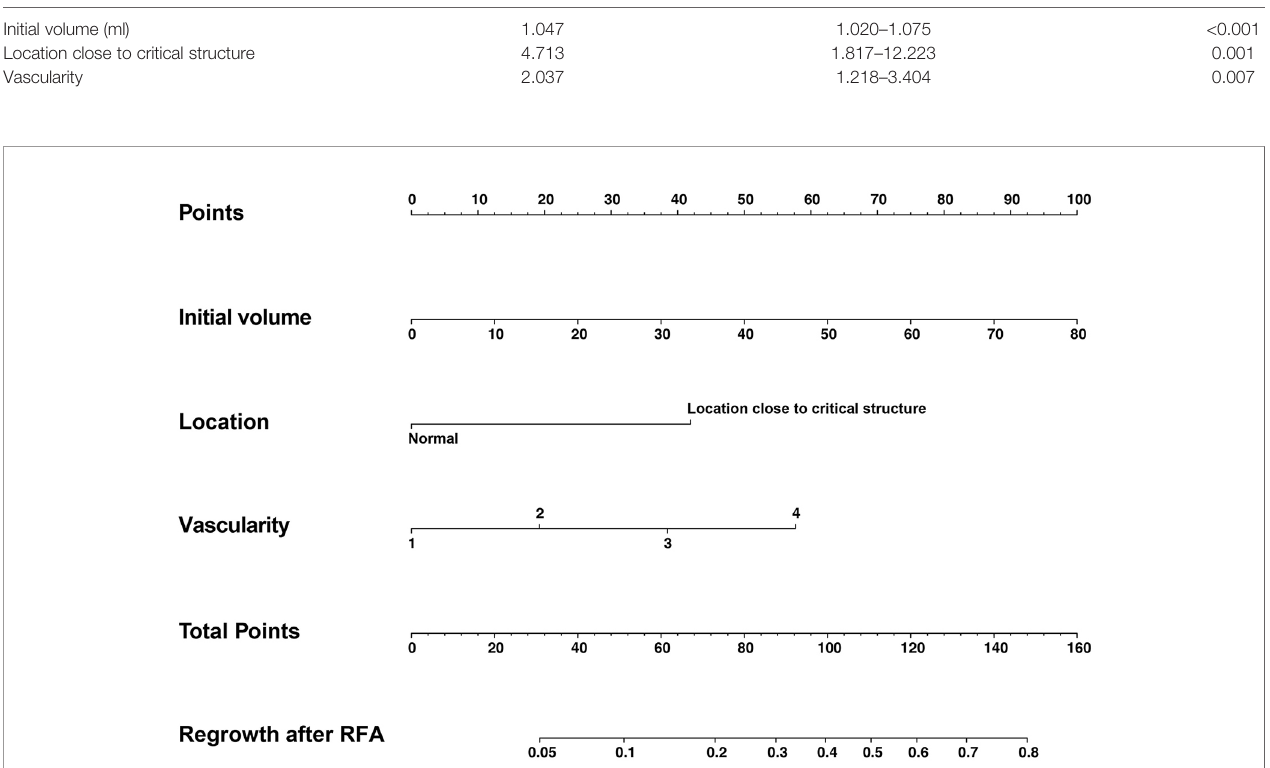
FIGURE 4 | The nomogram for predicting regrowth after RFA for benign thyroid nodules. A nomogram based on initial volume, vascularity and location was constructed.